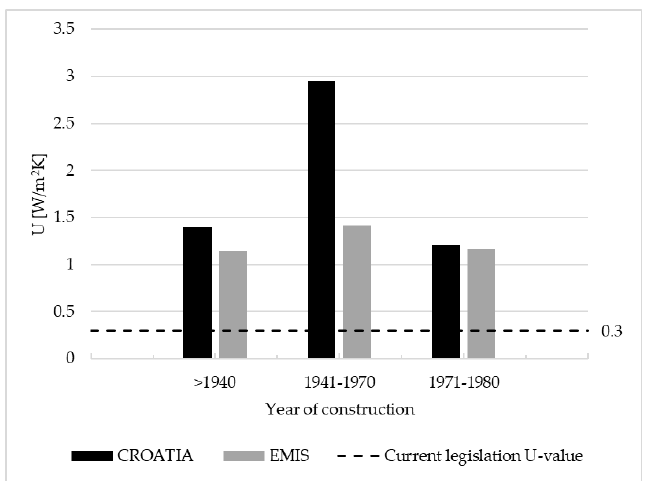
Figure 2. Characteristic U-values for external walls according to the year of construction.